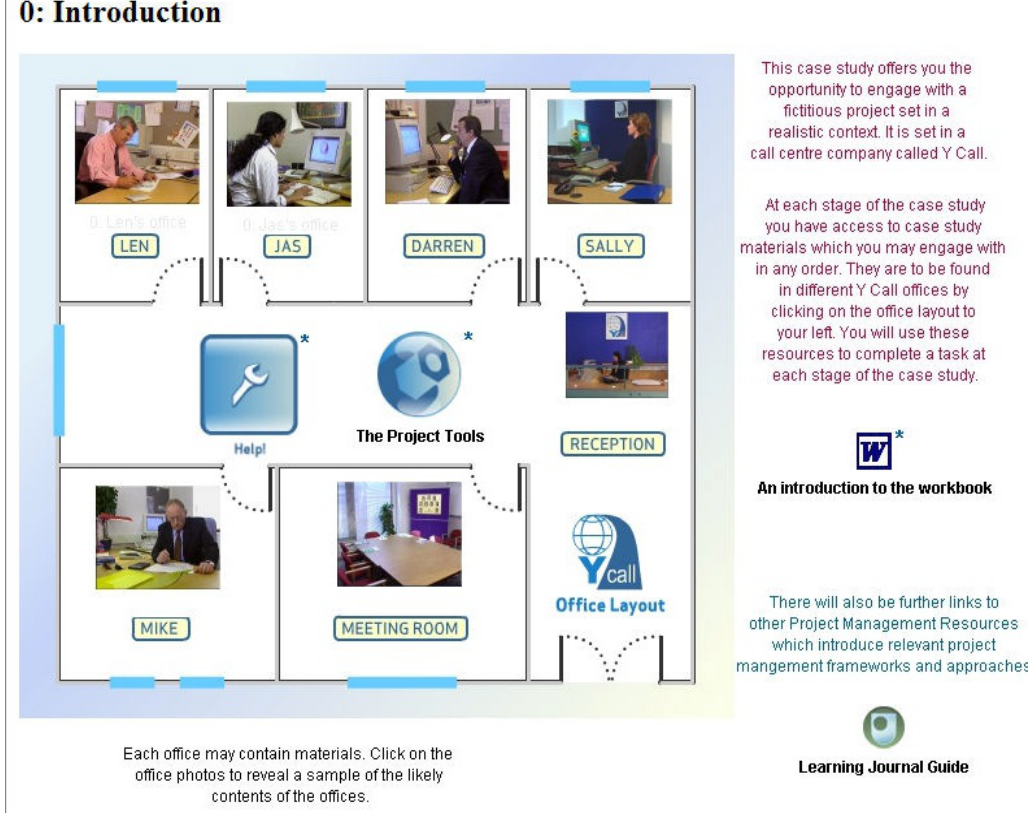
Figure 13 . An introduction to the Y Call Project Management stage